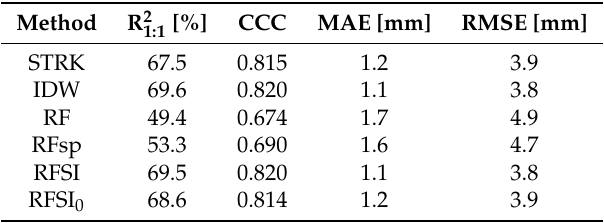
Table 4. Accuracy metrics of all six prediction methods as assessed using nested 5-fold LLOCV for the precipitation case